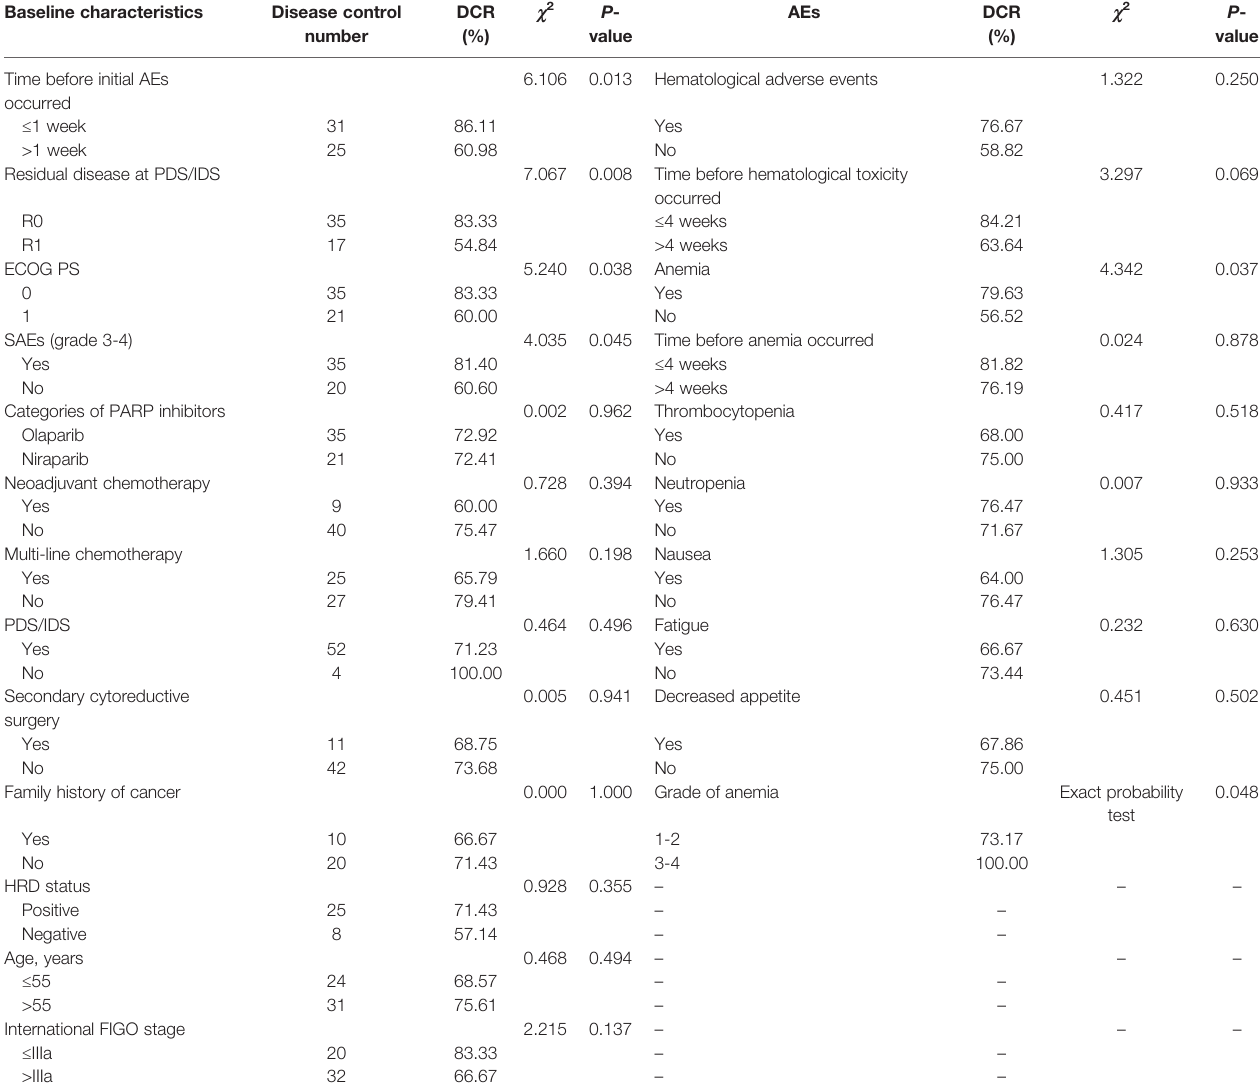
TABLE 1 | Disease control rate of patients with different baseline characteristics and adverse events. Baseline characteristics